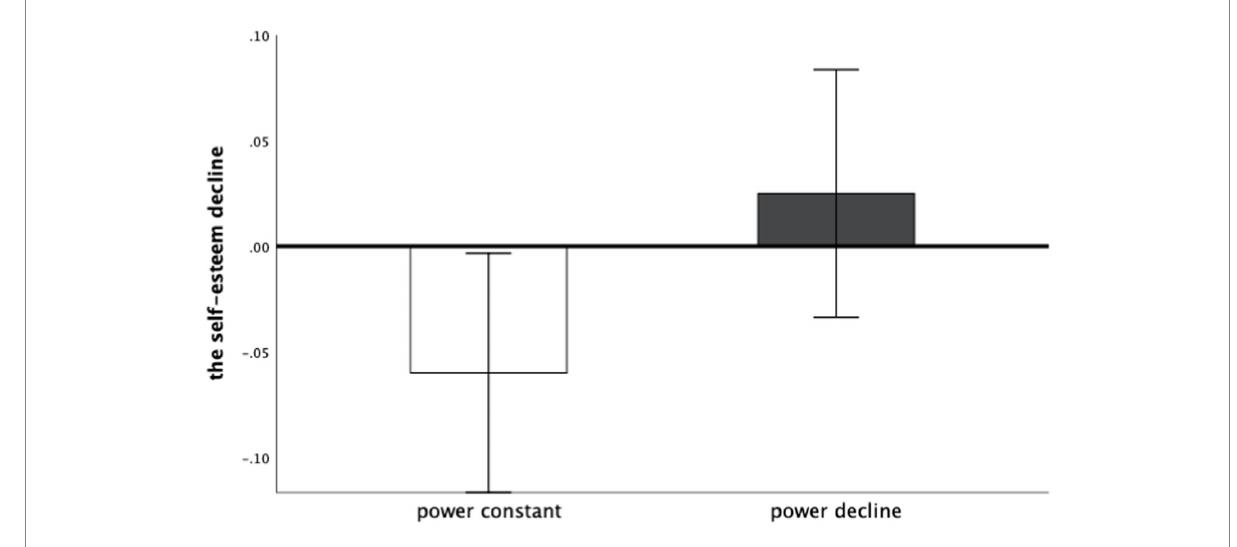
FIGURE 1 The self-esteem decline of different groups of Study